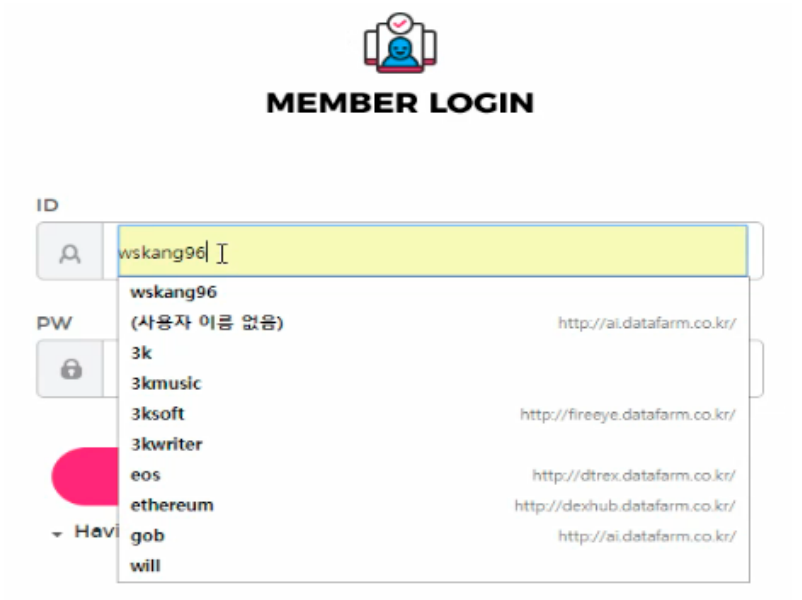
Figure 12. Main screen of Blockchain in smart contract real estate transactions.